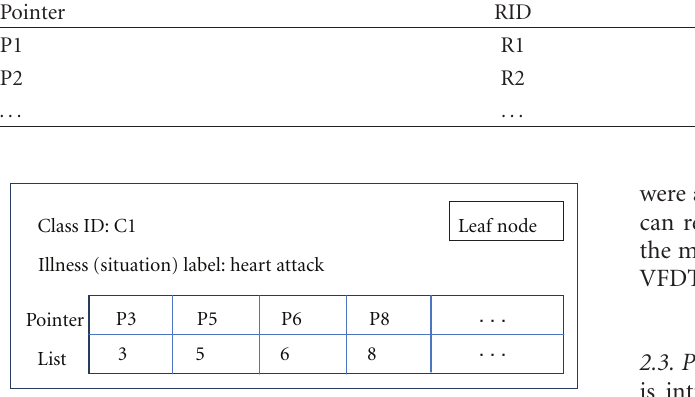
Figure 4: Pointer list in leaf